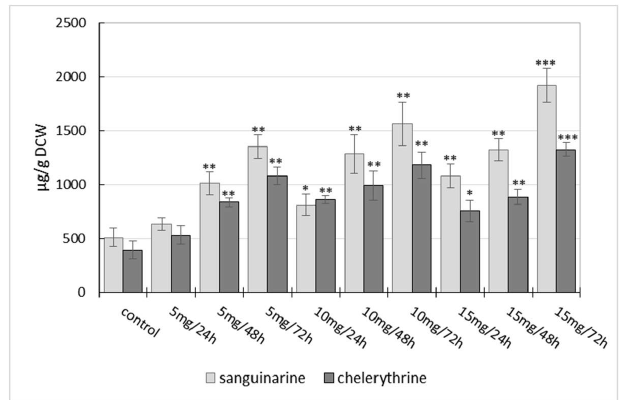
Figure 1. Time- and dose-dependent course of sanguinarine and chelerythrine production in cell suspension cultures of California poppy after MnCl 2 treatment. Values are means ± S.D from triplicate experiments ( n = 3). * p ≤ 0.05, ** p ≤ 0.01, *** p ≤ 0.001. DCW = dry cell weight.